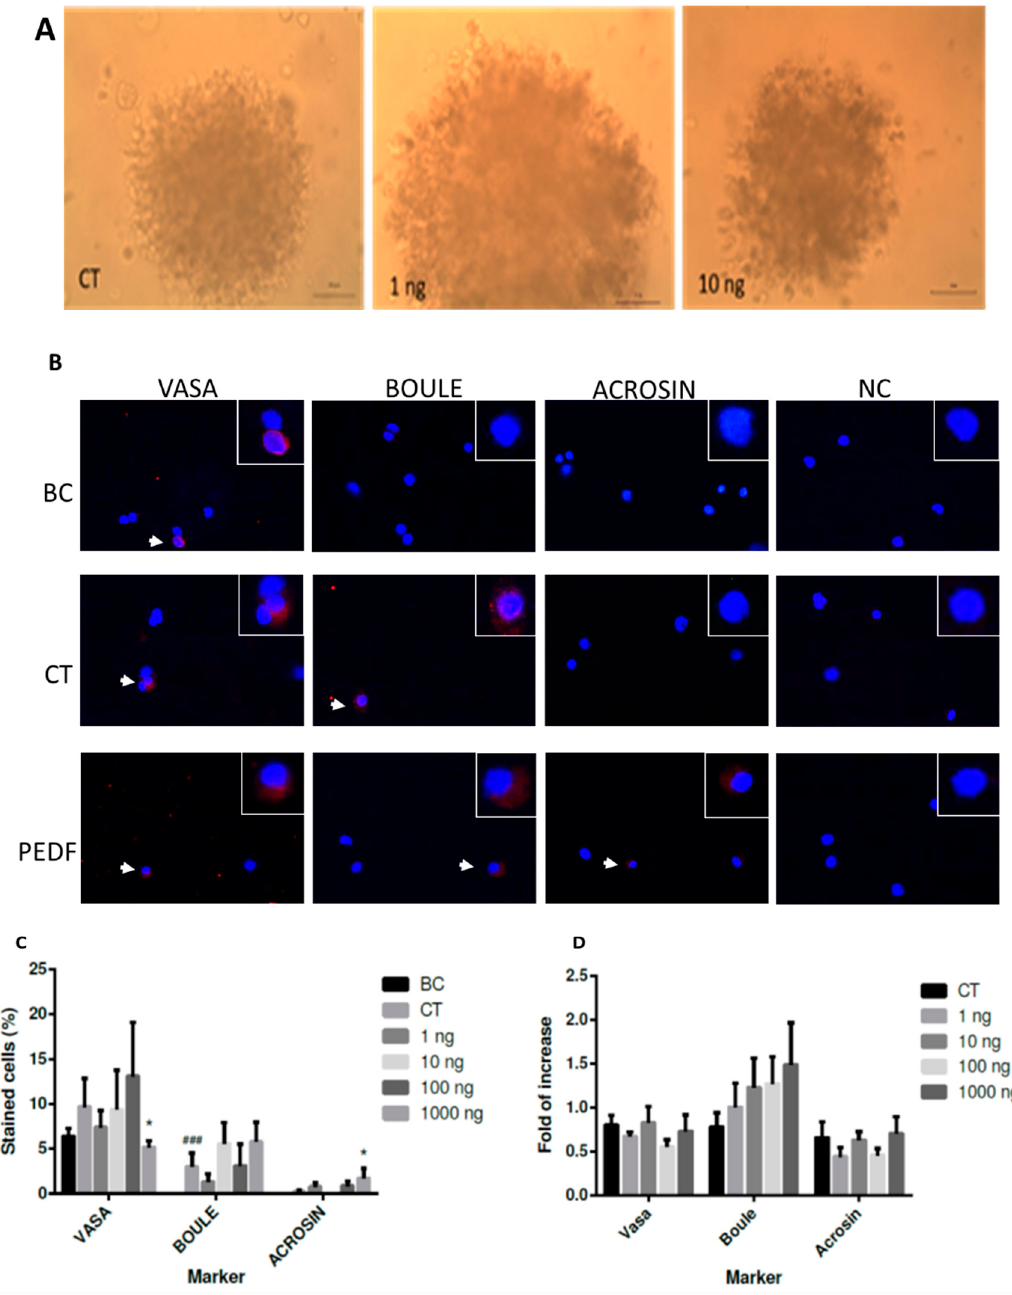
Figure 5. Effect of PEDF on the development of spermatogenesis in vitro. Cells isolated from seminiferous tubules of immature mice were cultured in methylcellulose in vitro culture system (MCS) as described in materials and methods. The cultures grew in the absence (CT) or in the presence of various concentrations of PEDF (1–10 ng/mL). The cultures were photographed after 4–5 weeks. × 20 magnification ( A ). The developed cultures in the absence of PEDF (CT) or presence of PEDF (PEDF) were collected, fixed and immunofluorescence stained in comparison to cells fixed before culture (BC) for spermatogenic markers: VASA (a premeiotic marker), BOULE (a meiotic marker) and ACROSIN (a meiotic/postmeiotic marker) ( B ). Negative control (NC)—immunofluorescence staining in the absence of the primary antibody. The percentage of VASA, BOULE and ACOSIN in the developed cultures were evaluated ( C ) and the expression levels of these markers were examined by qPCR analysis ( D ). #—Statistical significance in comparison to BC. ∗ —Statistical significance in comparison to CT. ( B ) N = 4–5, n = 10. ( C ) N = 3–5, n = 10. N—number of experiments. Number of mice in each experiment ∗ — p < 0.05, ###— p < 0.001. Scale bar: 100 μ m.